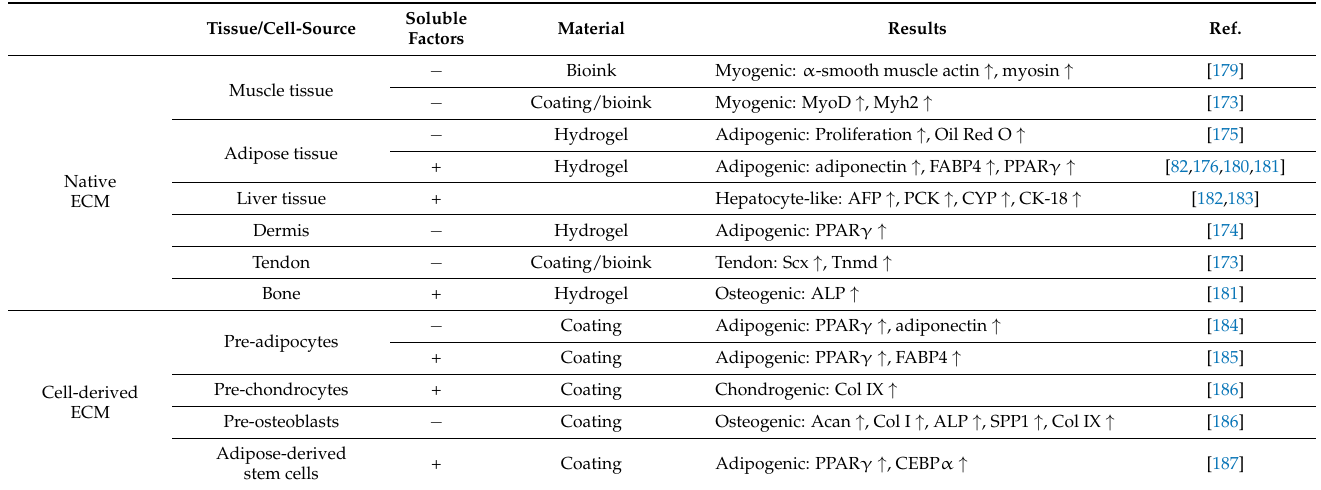
Table 6. Overview of the influence of natural ECM from native tissue and cultured cells on ASCs.